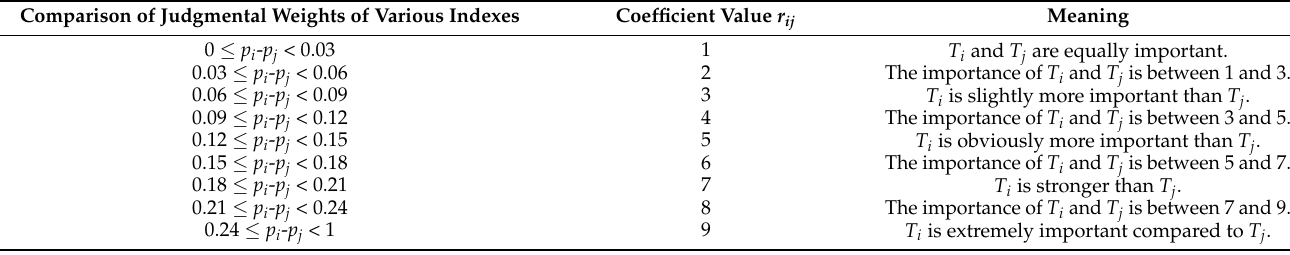
Table 1. Coefficient determination of the judgmental